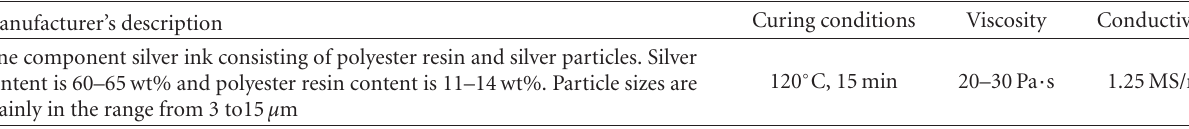
Table 1: Polymer thick film ink used in sample preparation.